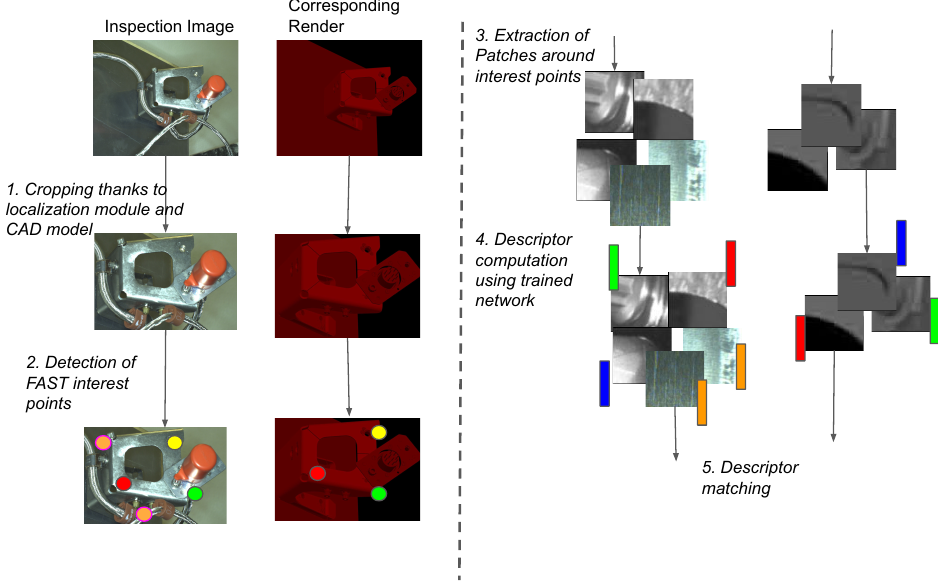
Figure 4. Proposed workflow for using the descriptor at test-time for nearest-neighbor one-to- one matching.